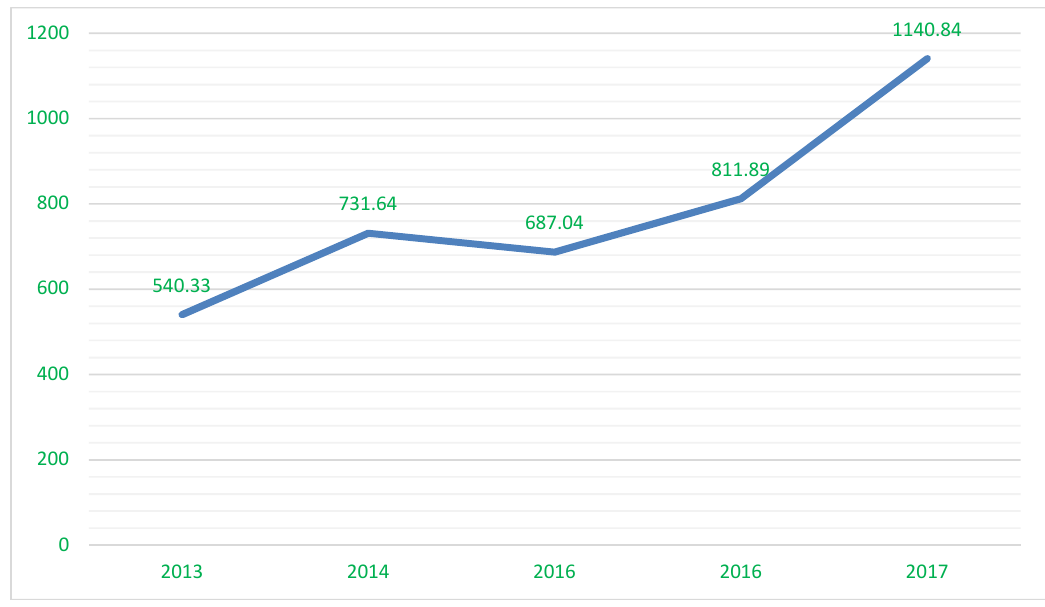
Fig. 1. Trend of the Financial Sector Stock Price Index for 2013-2017 Source: IDX and data processed by the author